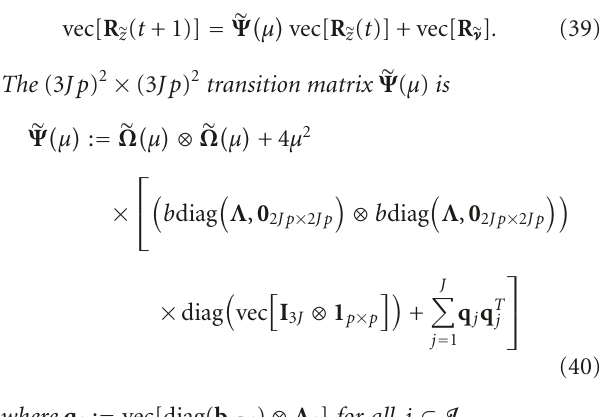
algorithm, under the white Gaussian setting